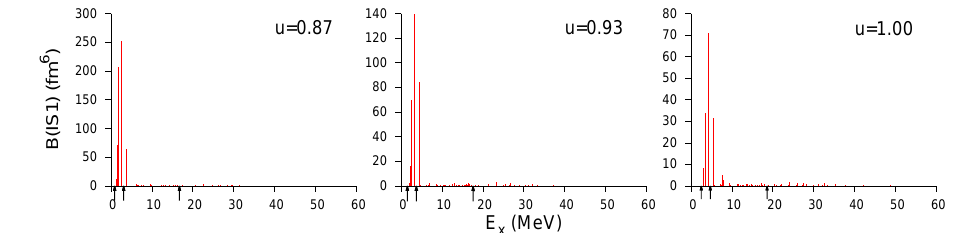
Figure 4: Isoscalar dipole transition strengths with u = 0.87, 0.93, and 1.00. The results with u = 0.93 are adopted from the data given in Ref. [ 3 ] .